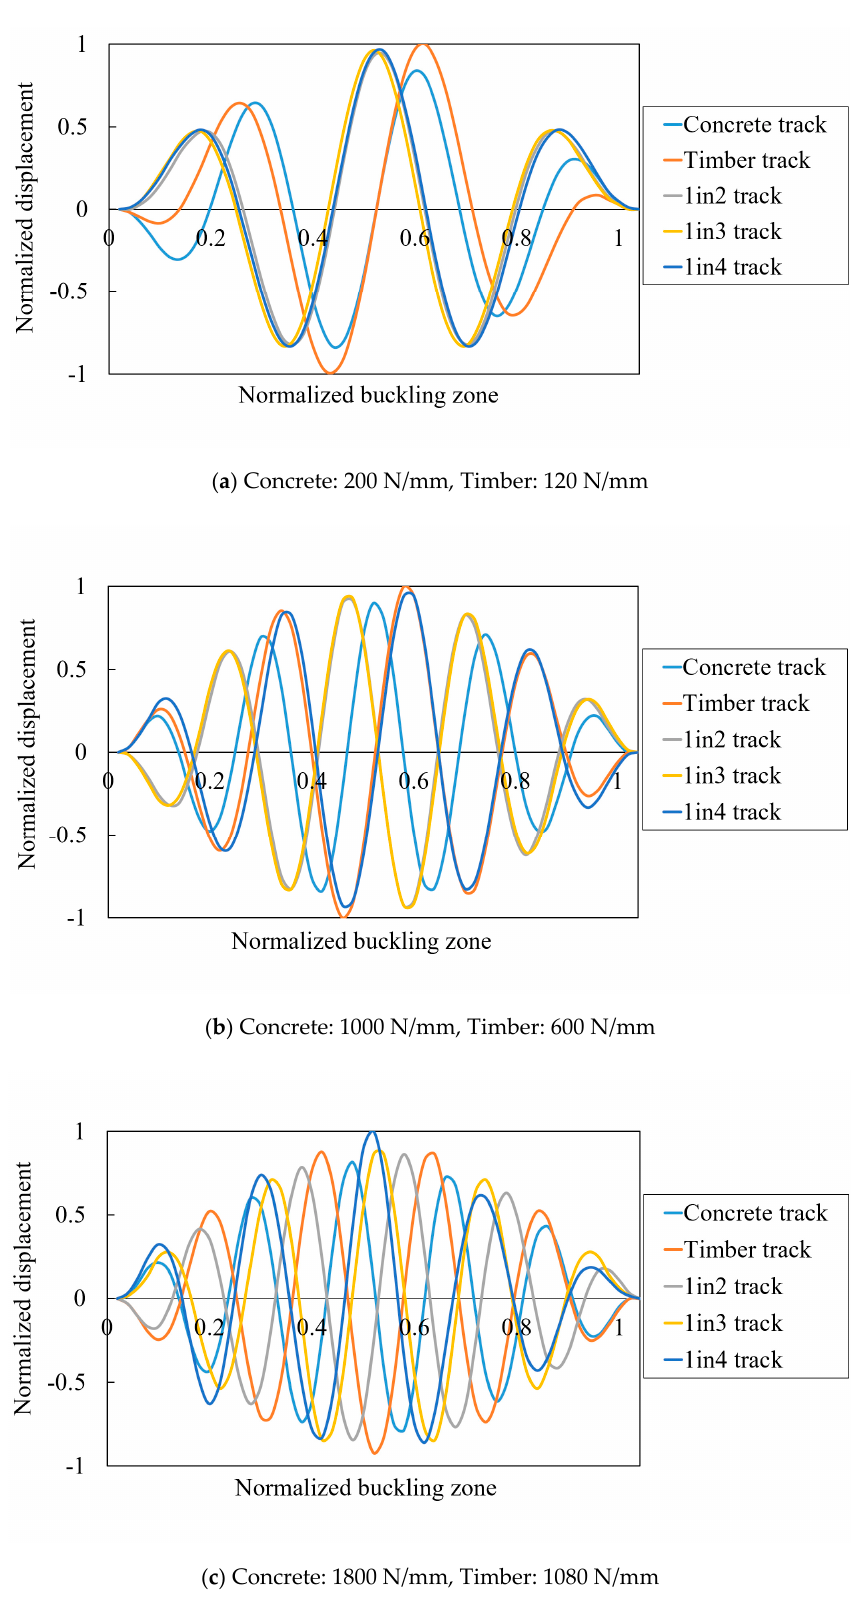
Figure 6. Buckling shapes and normalized displacements of railway tracks with different lateral Figure 6. resistances.